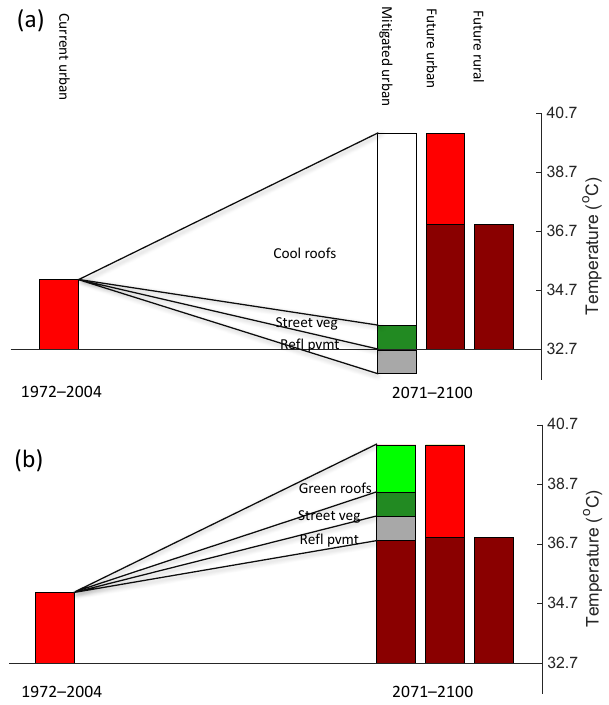
Figure 5. A UHI strategy consisting of three mitigation wedges un- der the RCP4.5 scenario. (a) cool roof, street vegetation, and re- flective pavement; (b) green roof, street vegetation, and reflective pavement. The horizontal line marks the mean midday rural sur- face temperature of all 57 cities in the current climate conditions, and other temperatures are mean values relative to this rural back-